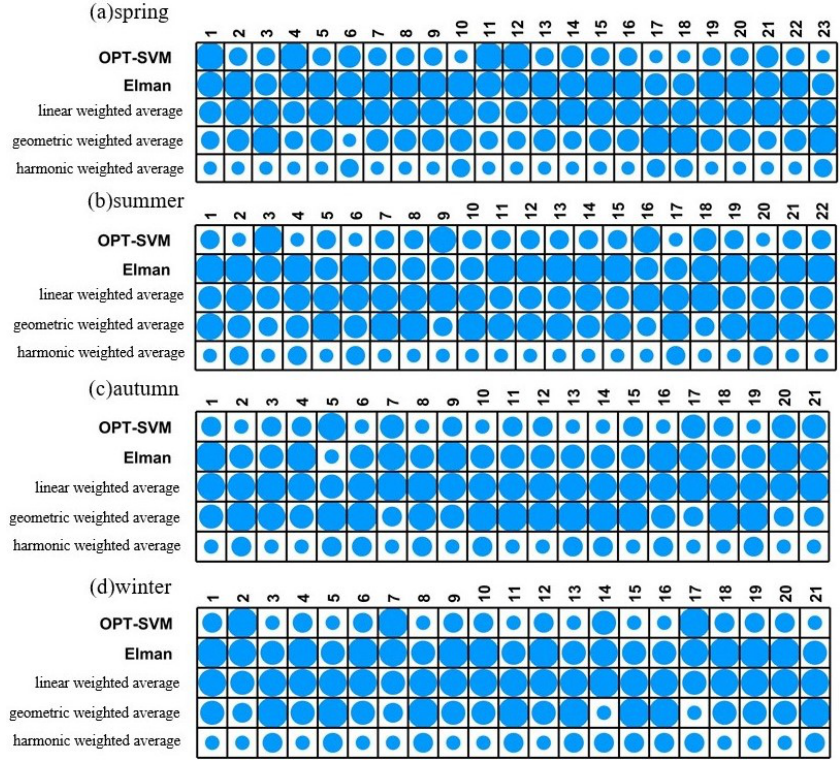
Figure 13. Prediction error ranking results for each period with different models. ( a ) Spring (March 1 to June 3); ( b ) Summer (June 4 to September 3); ( c ) Autumn (September 4 to December 3); ( d ) Winter (December 4 to February 28 of the following